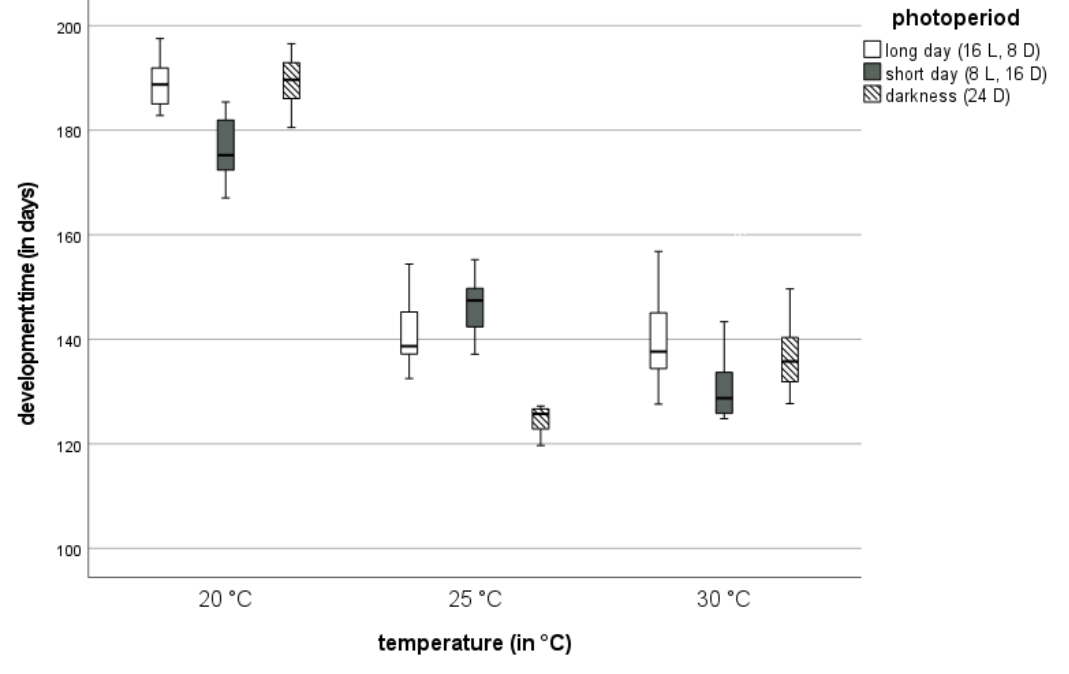
Figure 2. Developmental times (in days) of mealworms at three different temperatures (20 ◦ C, 25 ◦ C, and 30 ◦ C), grouped by three photoperiods: long day (LD), short day (SD), and constant darkness (24D).